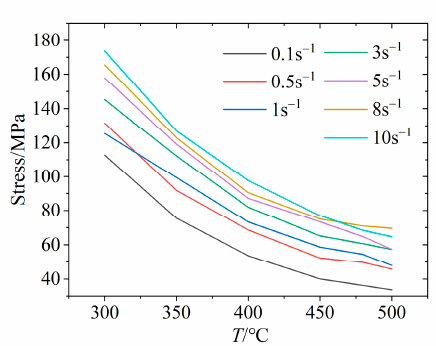
Figure 4. The influence of deformation temperature on steady flow stress.